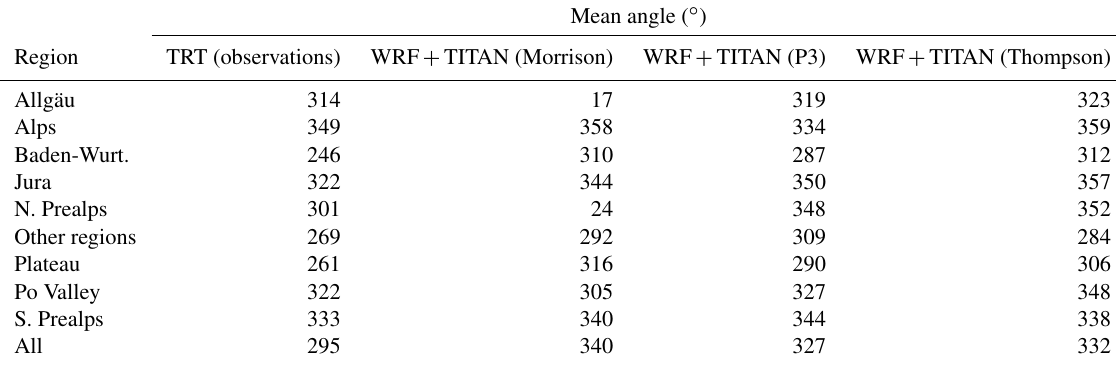
Table 6. Mean advection directions by